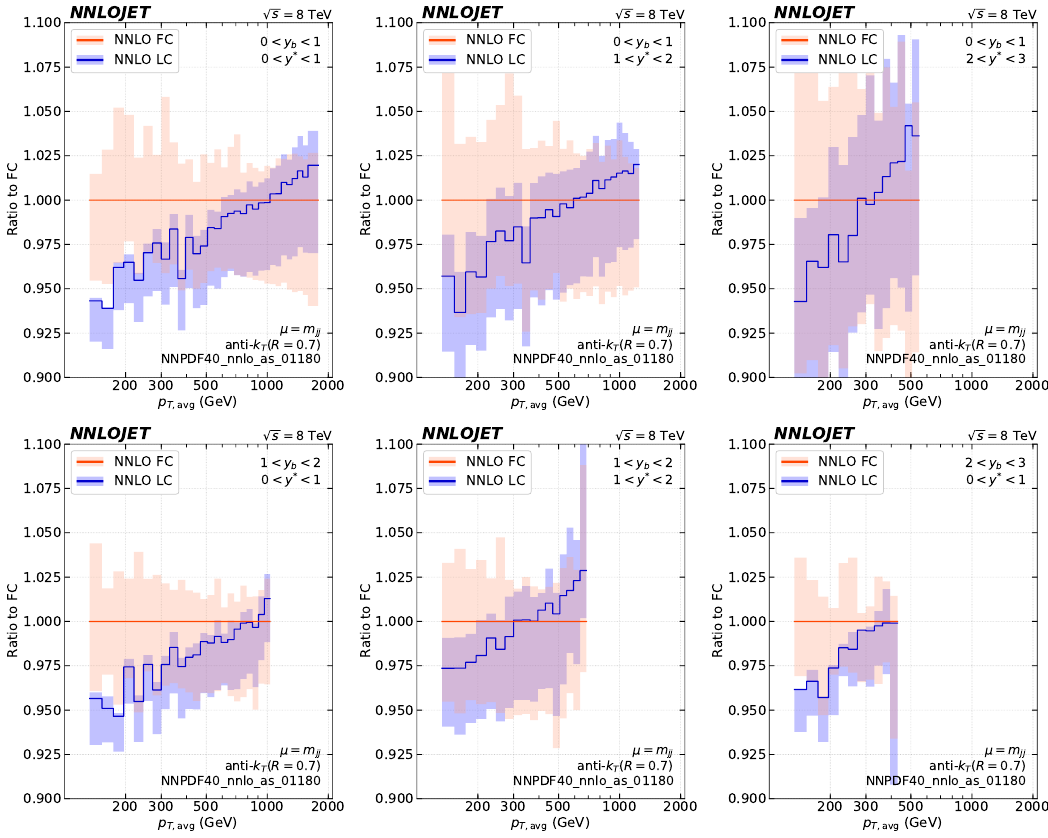
Figure 13 . NNLO LC (blue) and FC (red) predictions of the triple differential dijet distributions normalized to the FC